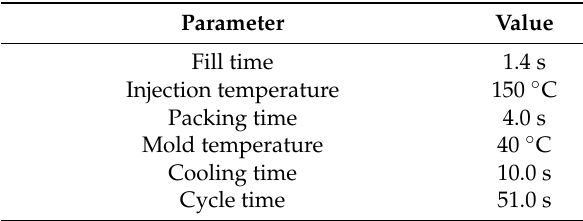
Table 7. Injection molding parameters used for experimental study.